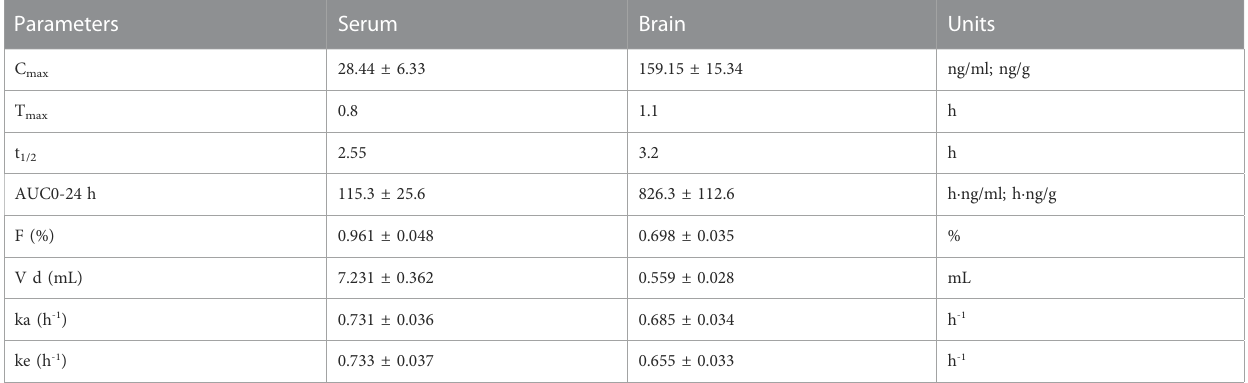
TABLE 1 Overview of pharmacokinetic parameters after 1 mg/kg s. c. 2C-B-Fly-NBOMe application. Data are presented as mean ± SEM.